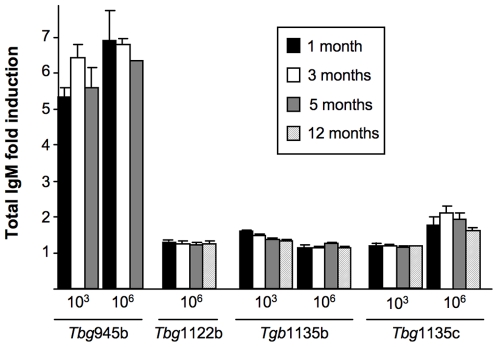
Time course of total serum IgM levels in BALB/c mice infected with different T. b. gambiense field isolates.Four mice were infected with either a low (103) or a high (106) load of Tbg945b, Tbg1122b, Tbg1135b or Tbg1135c isolates then IgM levels were quantified by ELISA test 1 month (black bars), 3 months (white bars), 5 months (gray bars) and 12 months (hatched bars) after infection. IgM levels are expressed as a multiple (mean±standard error) of the level before infection.